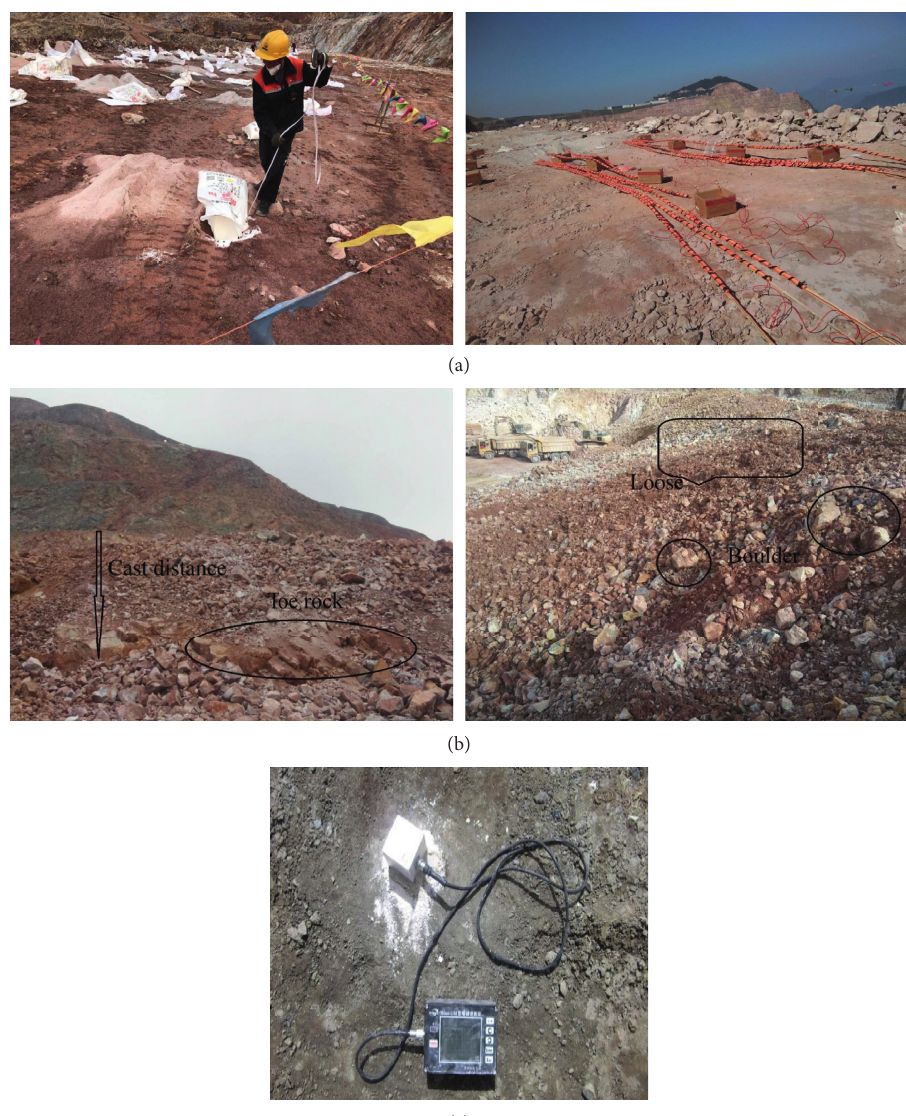
Figure 4: Explosion site and the effect after blasting. (a) Before the explosion. (b) After the explosion. (c) Mounting vibrometer.